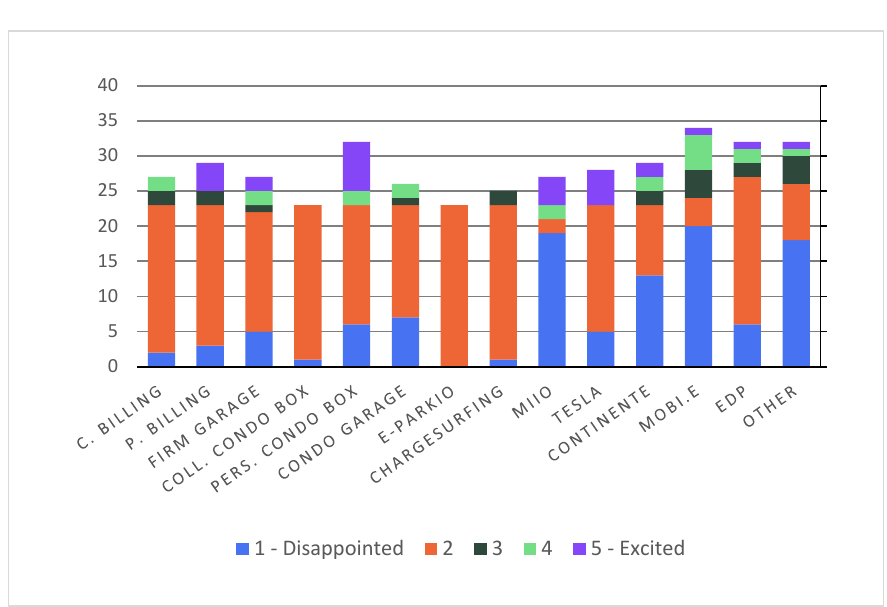
Figure 16. Satisfaction with EV charging solutions in Portugal.